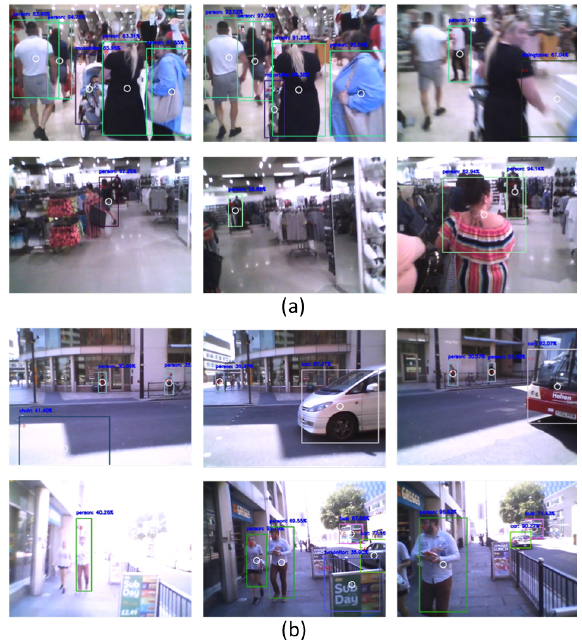
Figure 9. Examples captured by the Moverio BT-200 smart glasses. ( a ) indoor video frames; ( b ) outdoor